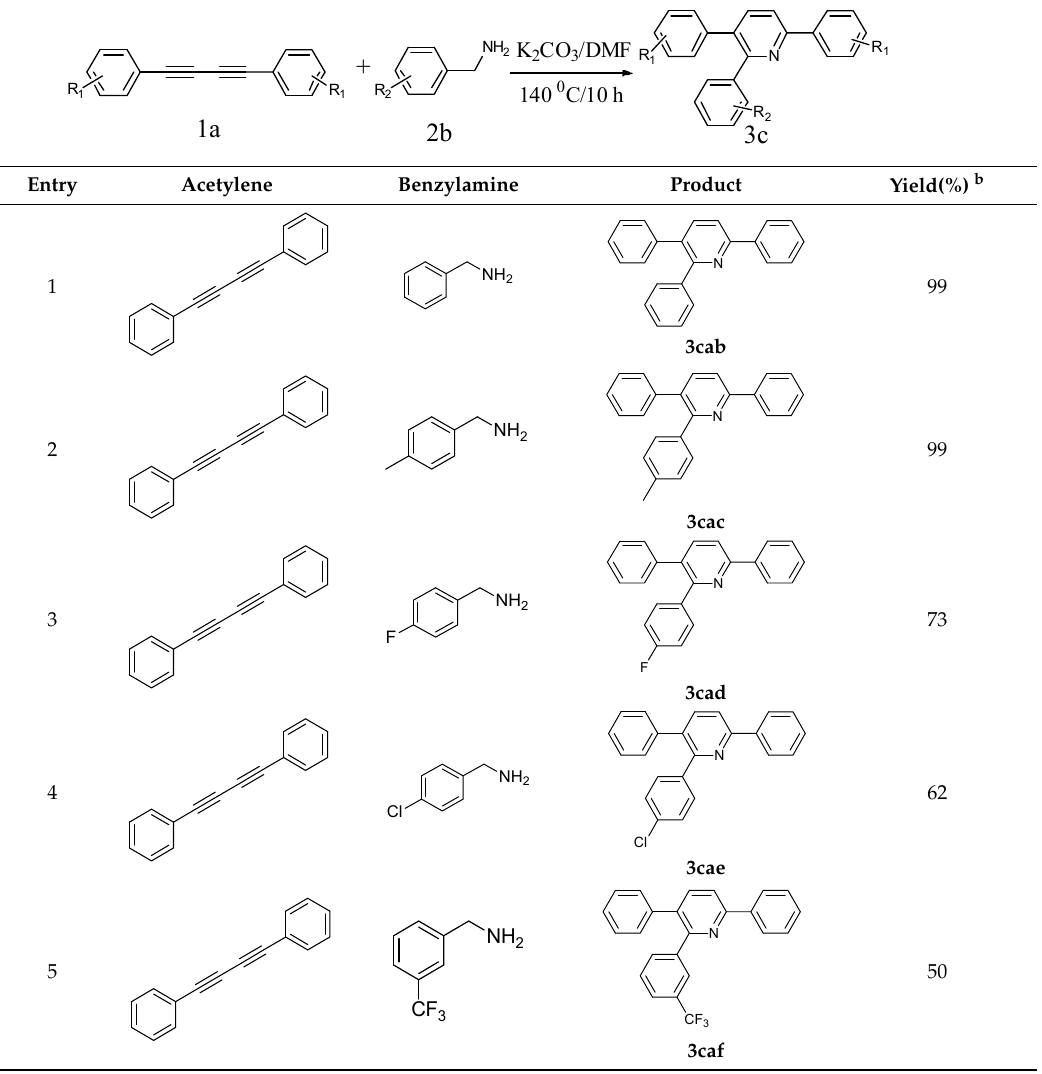
Table 2. Synthesis of arylated pyridines from conjugated acetylenes and substituted benzylamines under optimized conditions. a